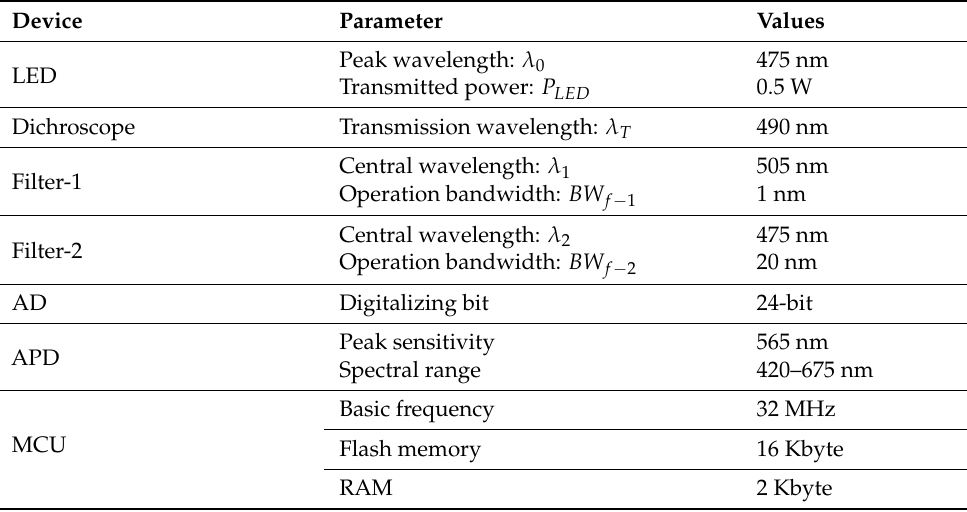
Table 1. Integrated fluorescence module parameters for detecting lucigenin.